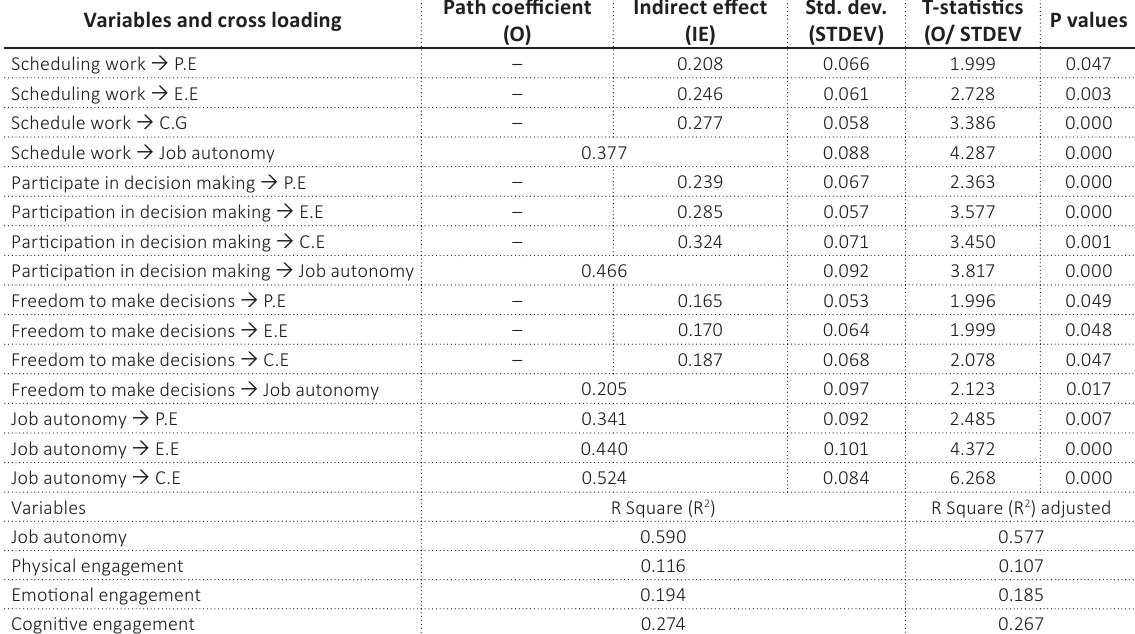
Table 2. Path coefficients for job autonomy and employee work engagement Variables and cross